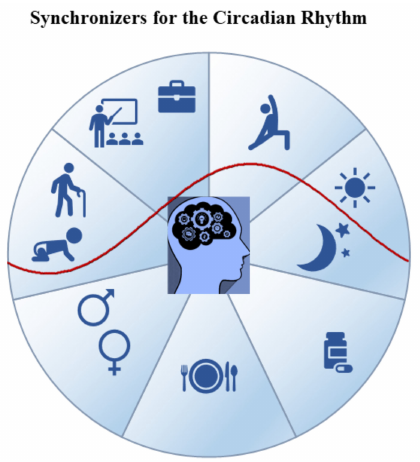
Figure 1. Factors influencing the rest–activity circadian rhythm and the sleep–wake